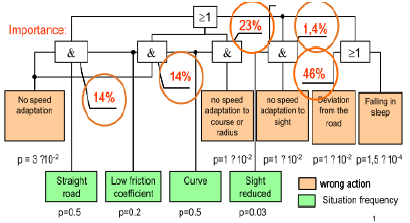
Fig. 7 Fault tree for the case “driving accident by street course or weather conditions 11 ” (“vehicle leave roadway accidents”)